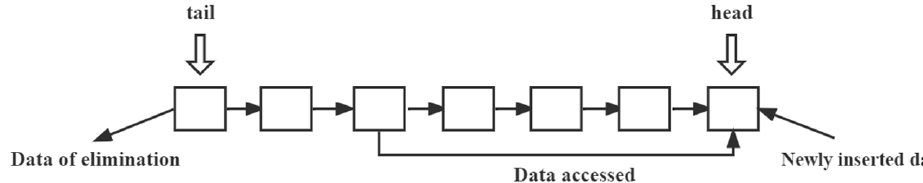
Figure 2. The idea of the LRU .